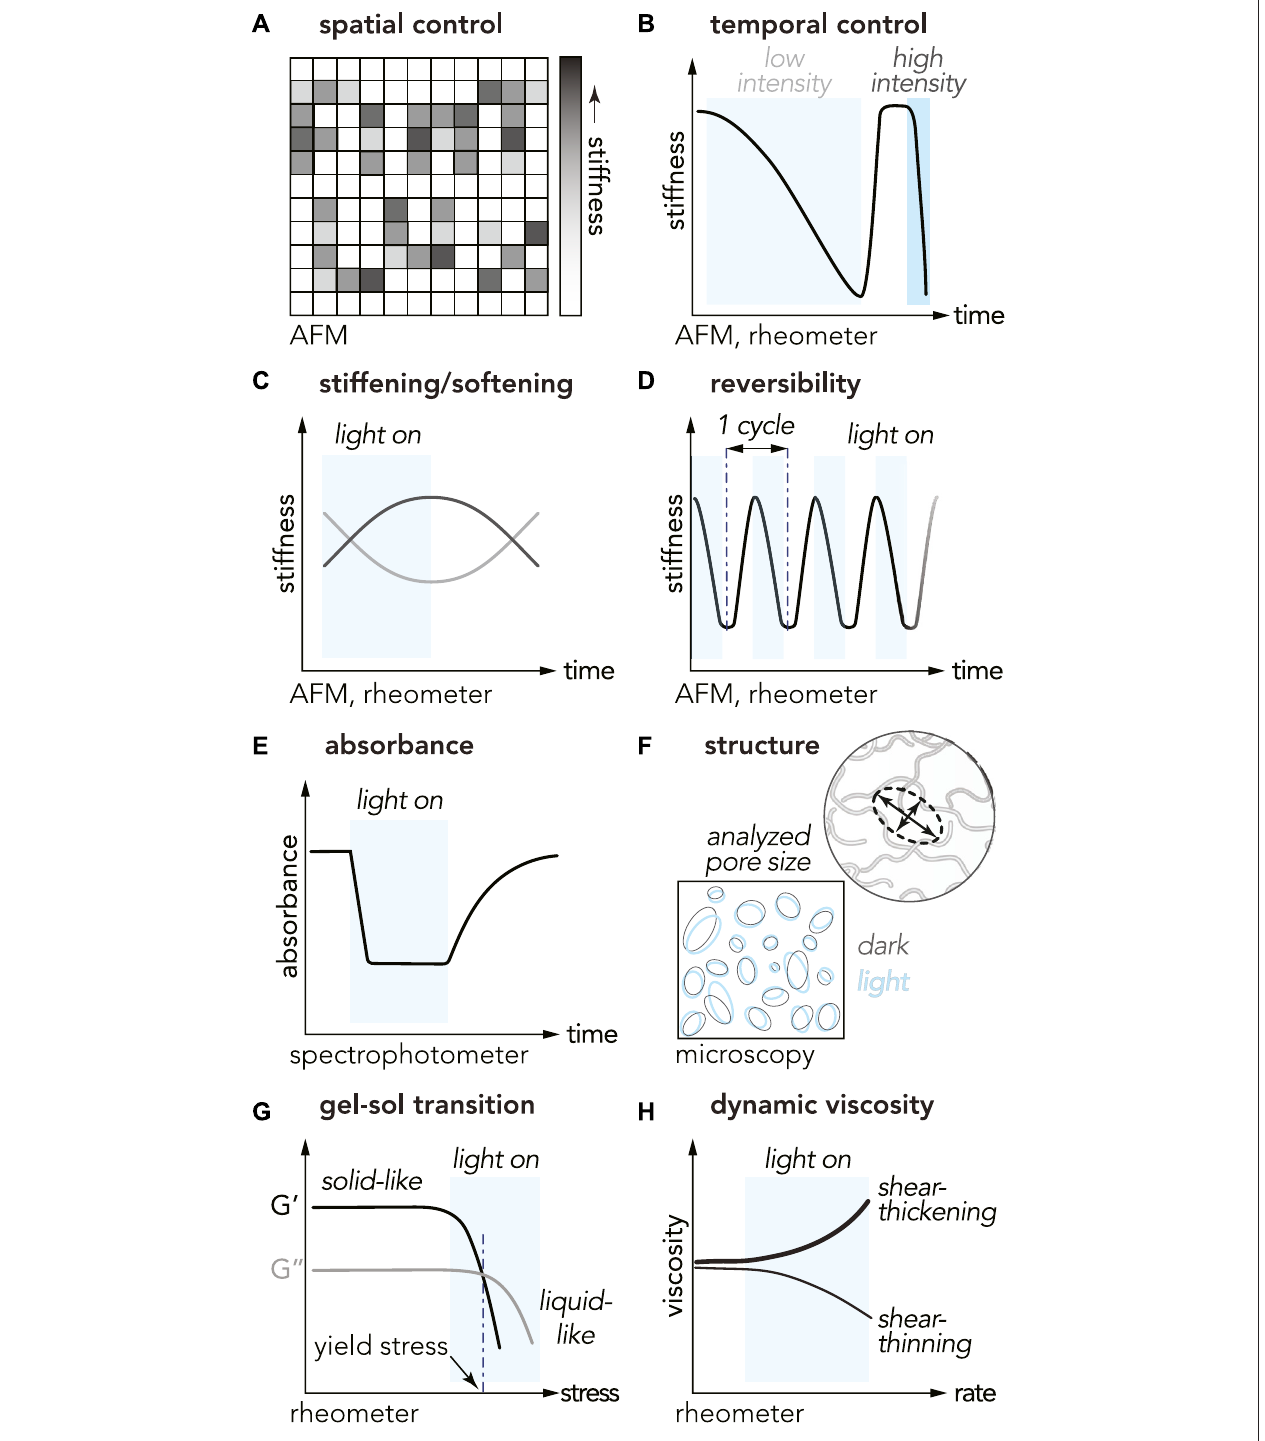
FIGURE 3 | Physical properties and characterization methods for studying opto-enabled materials. The cartoons illustrate characteristic trends observed with differentOptoGels (A) spatialcontrolofstiffness (B) temporalcontrolwithlightintensitydependenceforthetimeofswitch (C) stiffnesstuningwithlightON/OFF:stiffening (black curve) or softening (gray curve) in light (D) reversibility over multiple ON/OFF cycles (E) decreased absorbance during light-activation of optoprotein (F) material pore size comparison between light and dark states (G) gel-sol transition, and (H) shear thinning/thickening measurements.